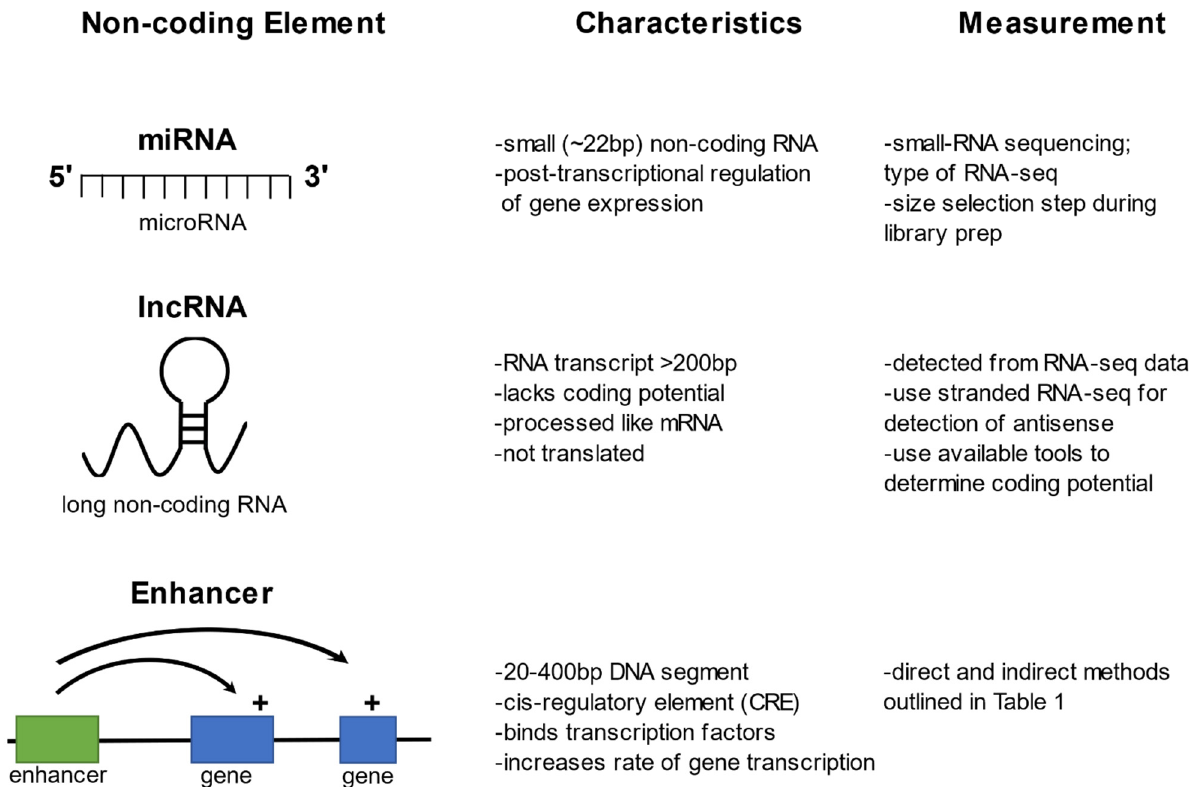
Figure 1. Three regulatory elements located in the non-coding portion of the genome.